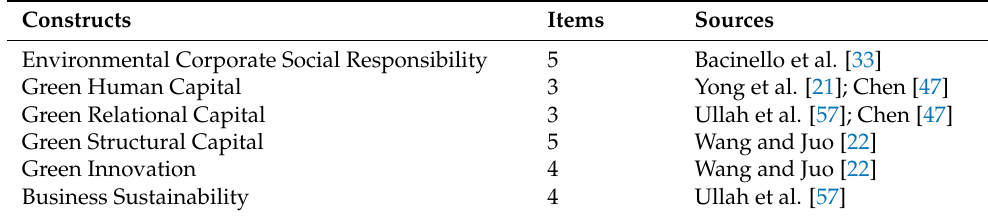
Table 3. Constructs’ measurement